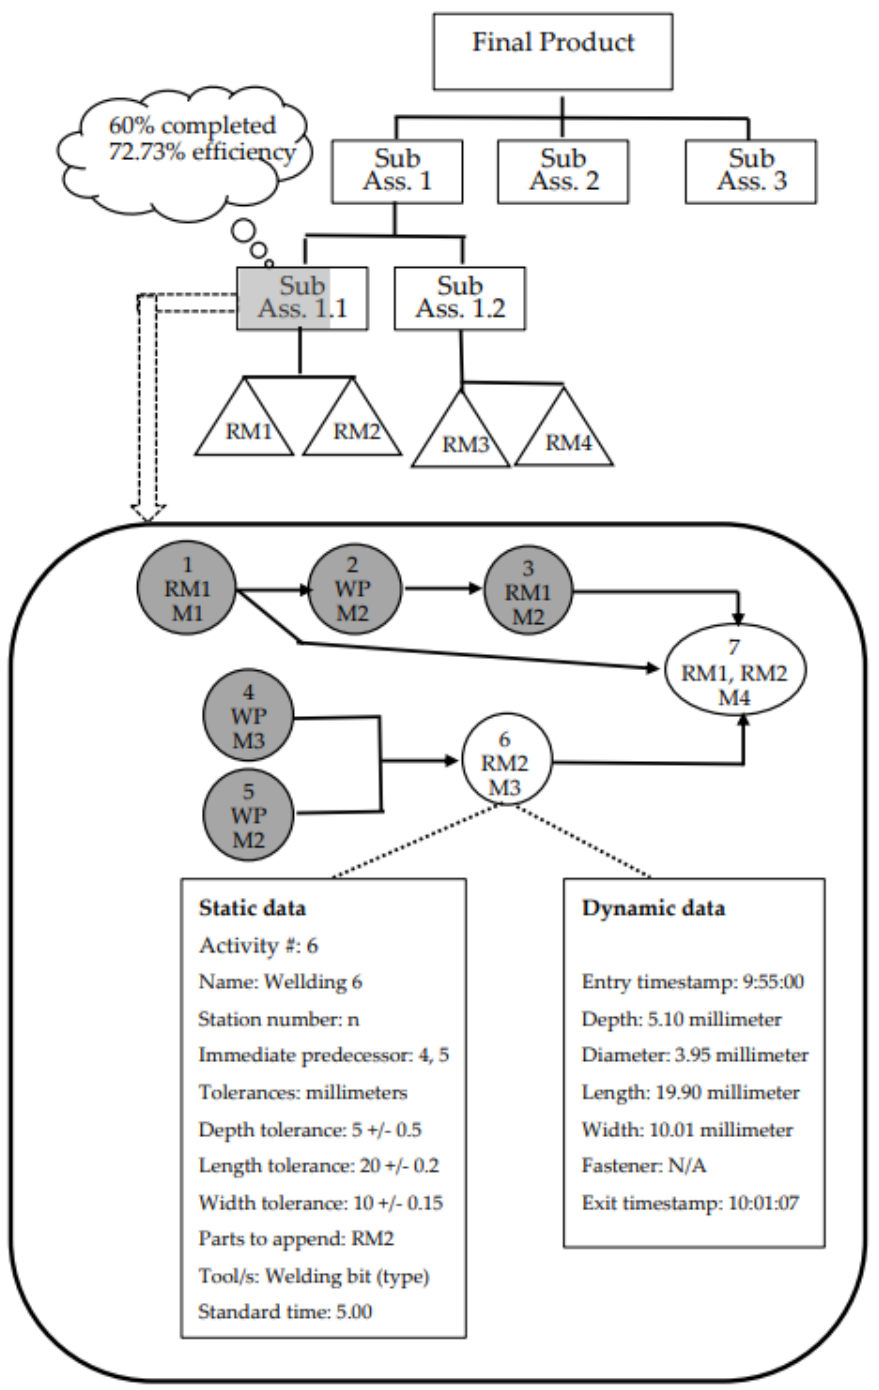
Figure 2. Bill of Assembly (BOA) Example: Exploded view.